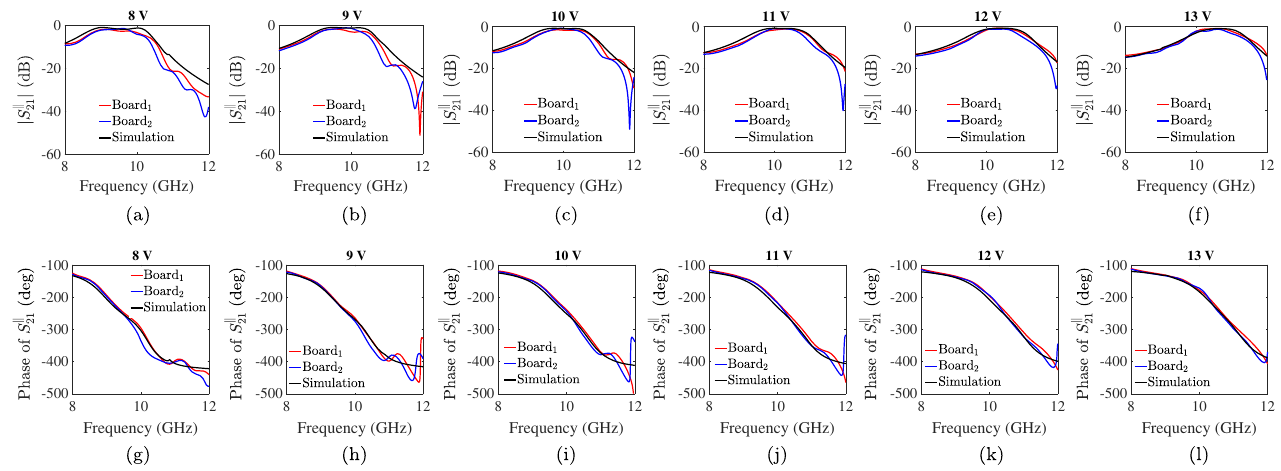
FIG. 20. Simulation and measurement results of the transmission coefficient for the parallel polarization of the birefringent boards, board 1 and board 2 , for various biasing voltages.